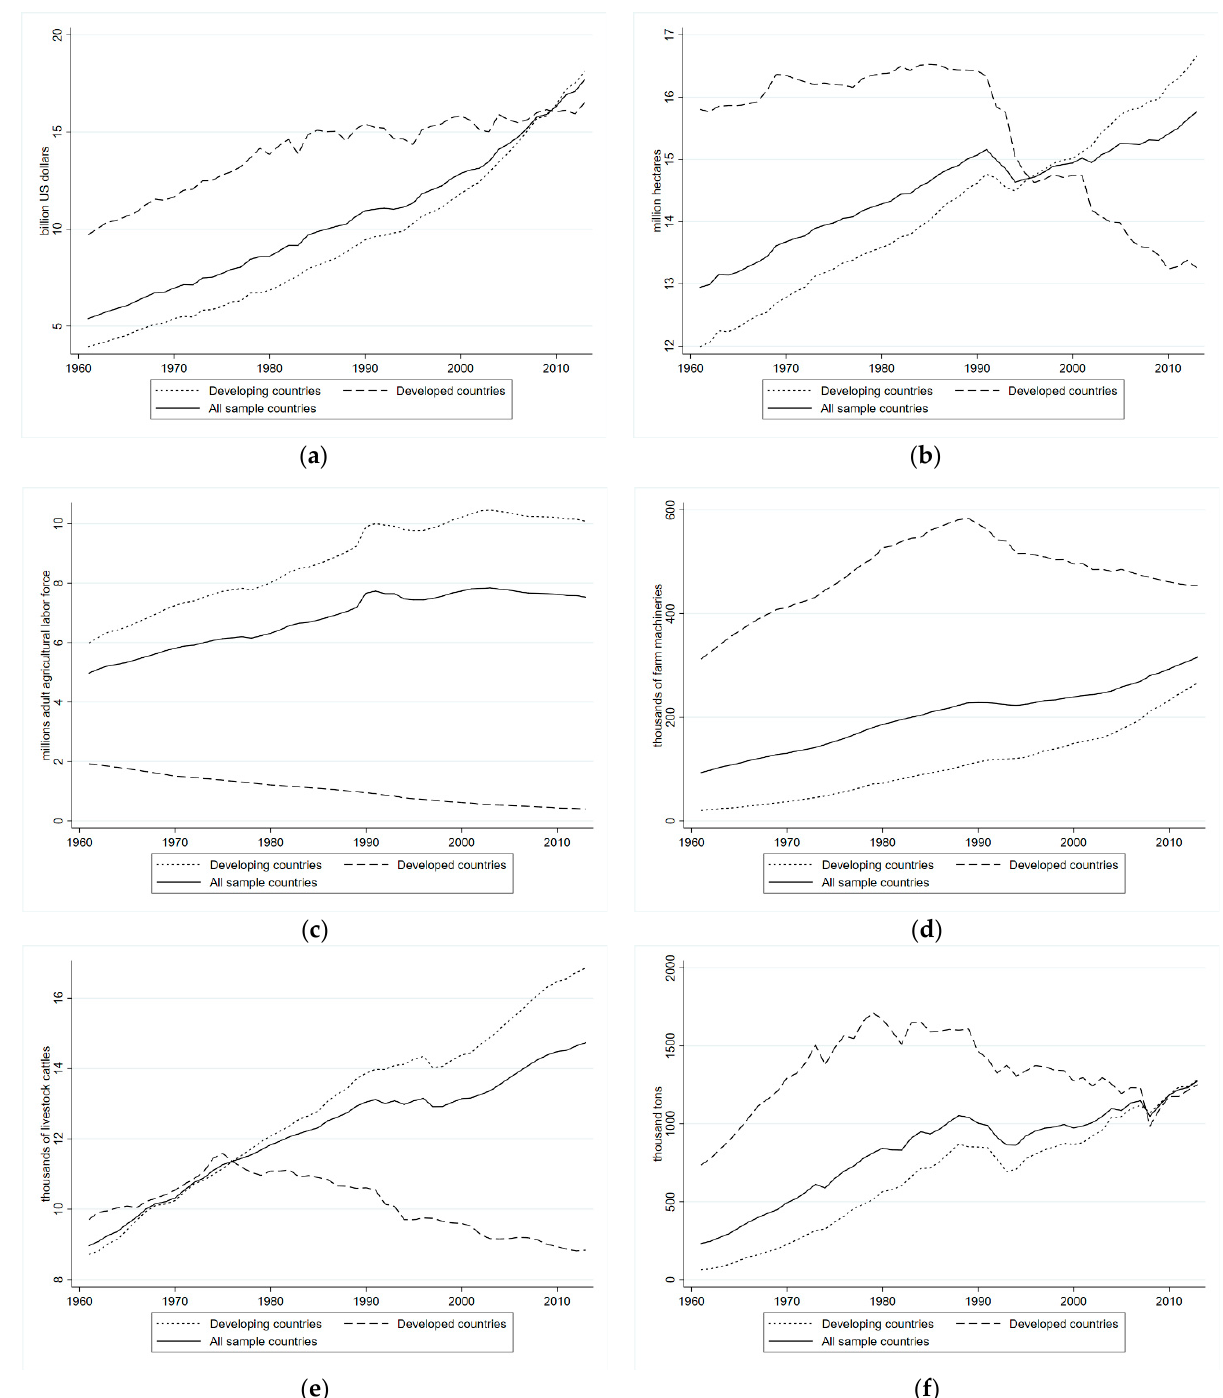
Figure 1. Change in agricultural output and inputs between developed and developing countries, 1961–2013: ( a ) agricultural total output; ( b ) land inputs; ( c ) labor inputs; ( d ) capital inputs; ( e ) live- stock inputs; ( f ) fertilizer inputs.